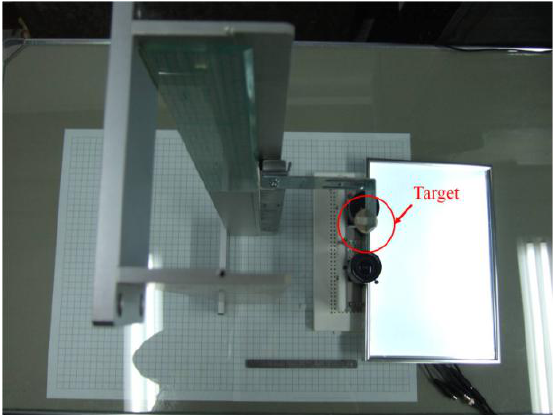
Figure 13. Measurement calibration